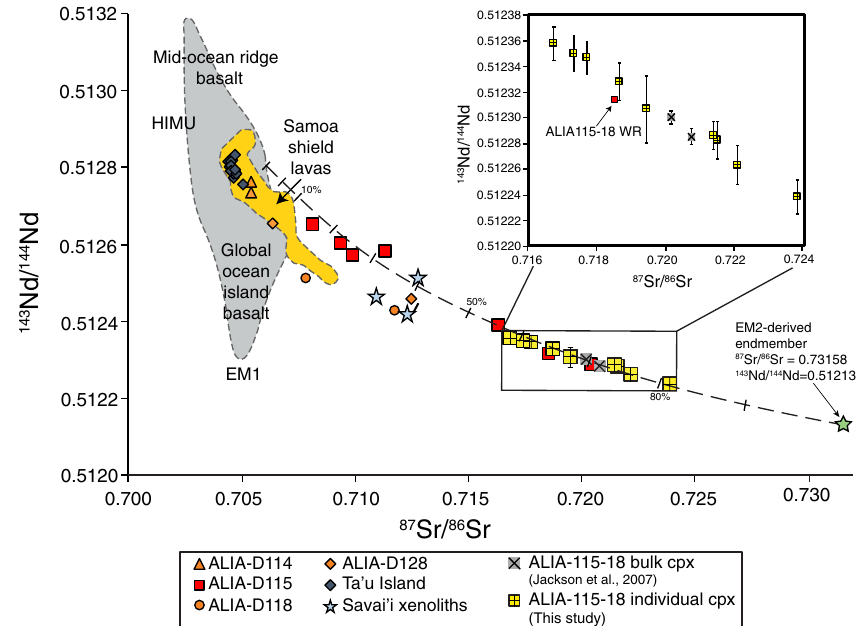
Fig. 1 143 Nd/ 144 Nd versus 87 Sr/ 86 Sr of new ALIA-D115-18 single clinopyroxene data and prior data on the whole rock and bulk (100s of grains of) clinopyroxene. Fields for Samoan shield lavas (excluding lavas from Savai ʼ i Island), and global OIB and mid-ocean ridge basalts, are shown in orange and gray fi elds, respectively. Other Samoan shield lavas from the ALIA dataset (i.e., submarine shield lavas from Savai ʼ i Island) are shown for reference as well (i.e. ALIA-D114: orange triangles, ALIA-D115: red squares, ALIA-D118: orange circles, and ALIA-D128 lavas: orange diamonds, and the new clinopyroxene data, denoted as yellow crossed squares, collected in this study) 7 . The inset shows a zoomed view of the clinopyroxene data in addition to the bulk clinopyroxene analyses (representing 100s of pooled grains; gray squares with an “ x ” ) and the ALIA-D115-18 whole rock (red square) published previously 7,8 . All error bars smaller than symbols except where shown and represent 2 σ standard errors. Note that only nine of the 17 clinopyroxenes analyzed for 87 Sr/ 86 Sr also have 143 Nd/ 144 Nd data, so not all clinopyroxenes analyzed for 87 Sr/ 86 Sr can be shown on this fi gure. However, the nine clinopyroxenes analyzed for both Sr and Nd isotopes encompass the full range of 87 Sr/ 86 Sr observed in this study. Samoan shield lavas, ALIA lavas, and Savai ’ i xenolith compositions are from elsewhere 5 – 7,69 . The black dashed line is a theoretical magma mixing line derived in this study using binary mixing theory; mixing endmember compositions are provided in Supplementary Table 2, and methods for calculating endmembers are discussed in the text. Each hatch is a 10% increment except for the fi rst two hatches, which are in 5% increments. The green star denotes the EM2-derived, high 87 Sr/ 86 Sr, trachytic mixing endmember calculated in this study (see Supplementary Table